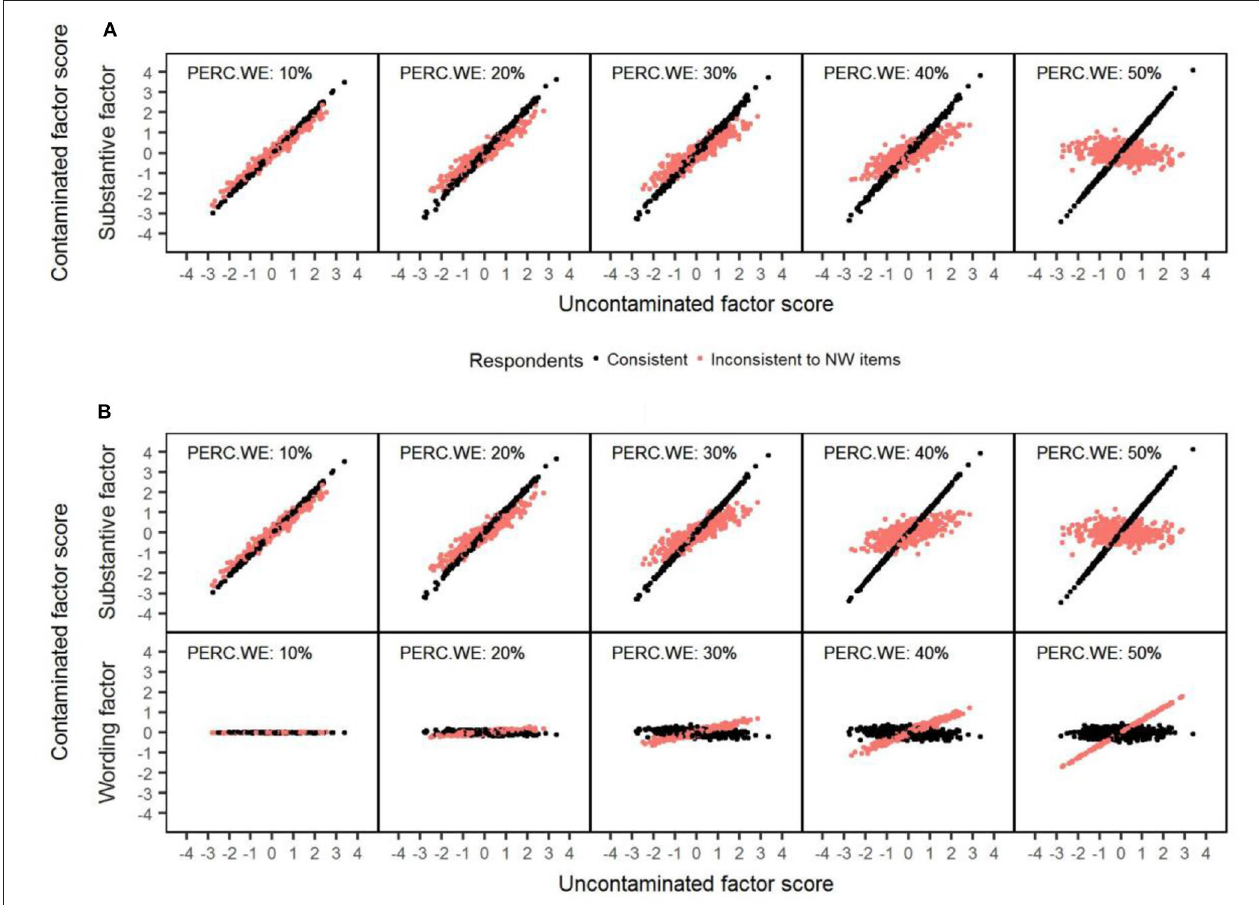
FIGURE 4 | Example of recovery of the substantive factor scores with the 1F and RIIFA models in the presence of carelessness. The data represented corresponds to simulated unidimensional data sets with 1,000 respondents and 20 variables. 1F, unidimensional model with one substantive factor; RIIFA, random intercept item factor analysis model with one substantive factor and one wording method factor; PERC.WE, amount of wording effect; NW, negatively worded. (A) 1F model. (B) RIIFA